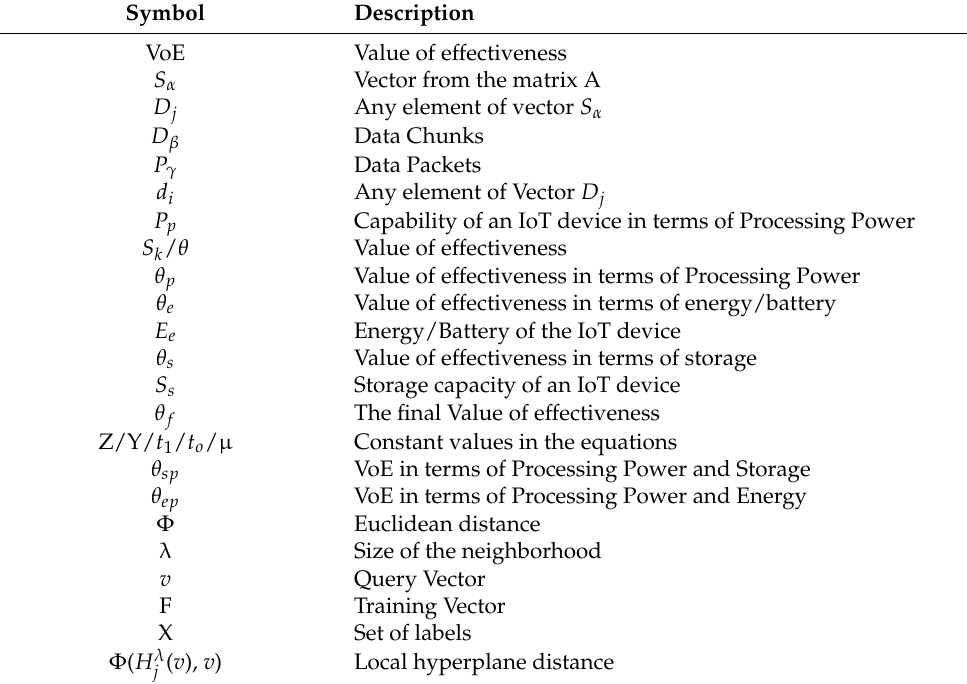
Table 2. List of